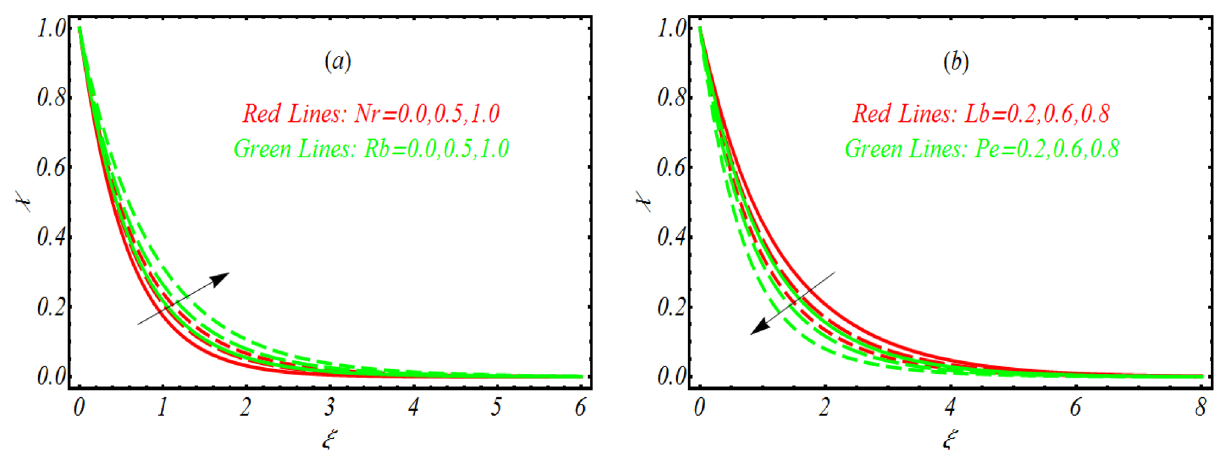
Figure 6. Variation of χ for various values of ( a ) Nr and Rb ( b ) Lb and Pe